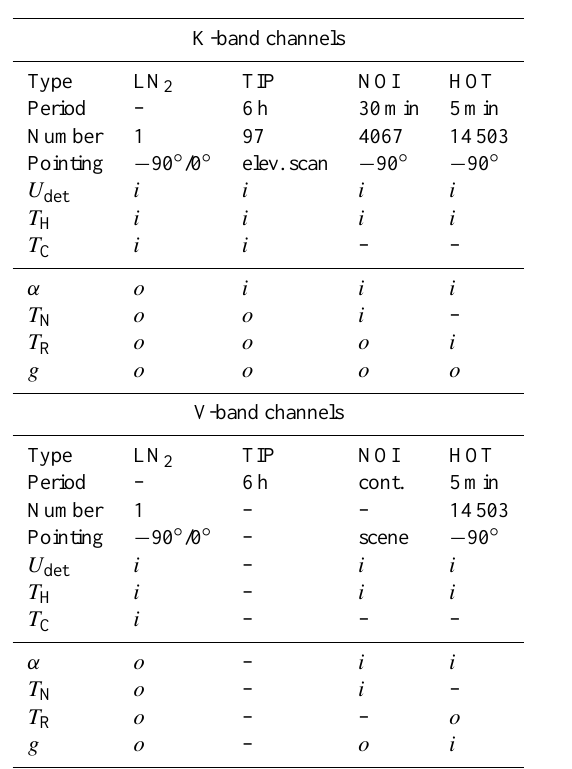
Table 1. Information on the standard calibration schedule during RHUBC-II. For both frequency bands the type, repetition period and number is given: liquid nitrogen calibration (LN 2 ), tipping curve calibrations (TIP), noise diode calibrations (NOI) and hot load calibrations (HOT). Pointing: 90.0 ◦ =internal ambient target, 0.0 ◦ =LN 2 target; i =input parameter, o =output parameter.